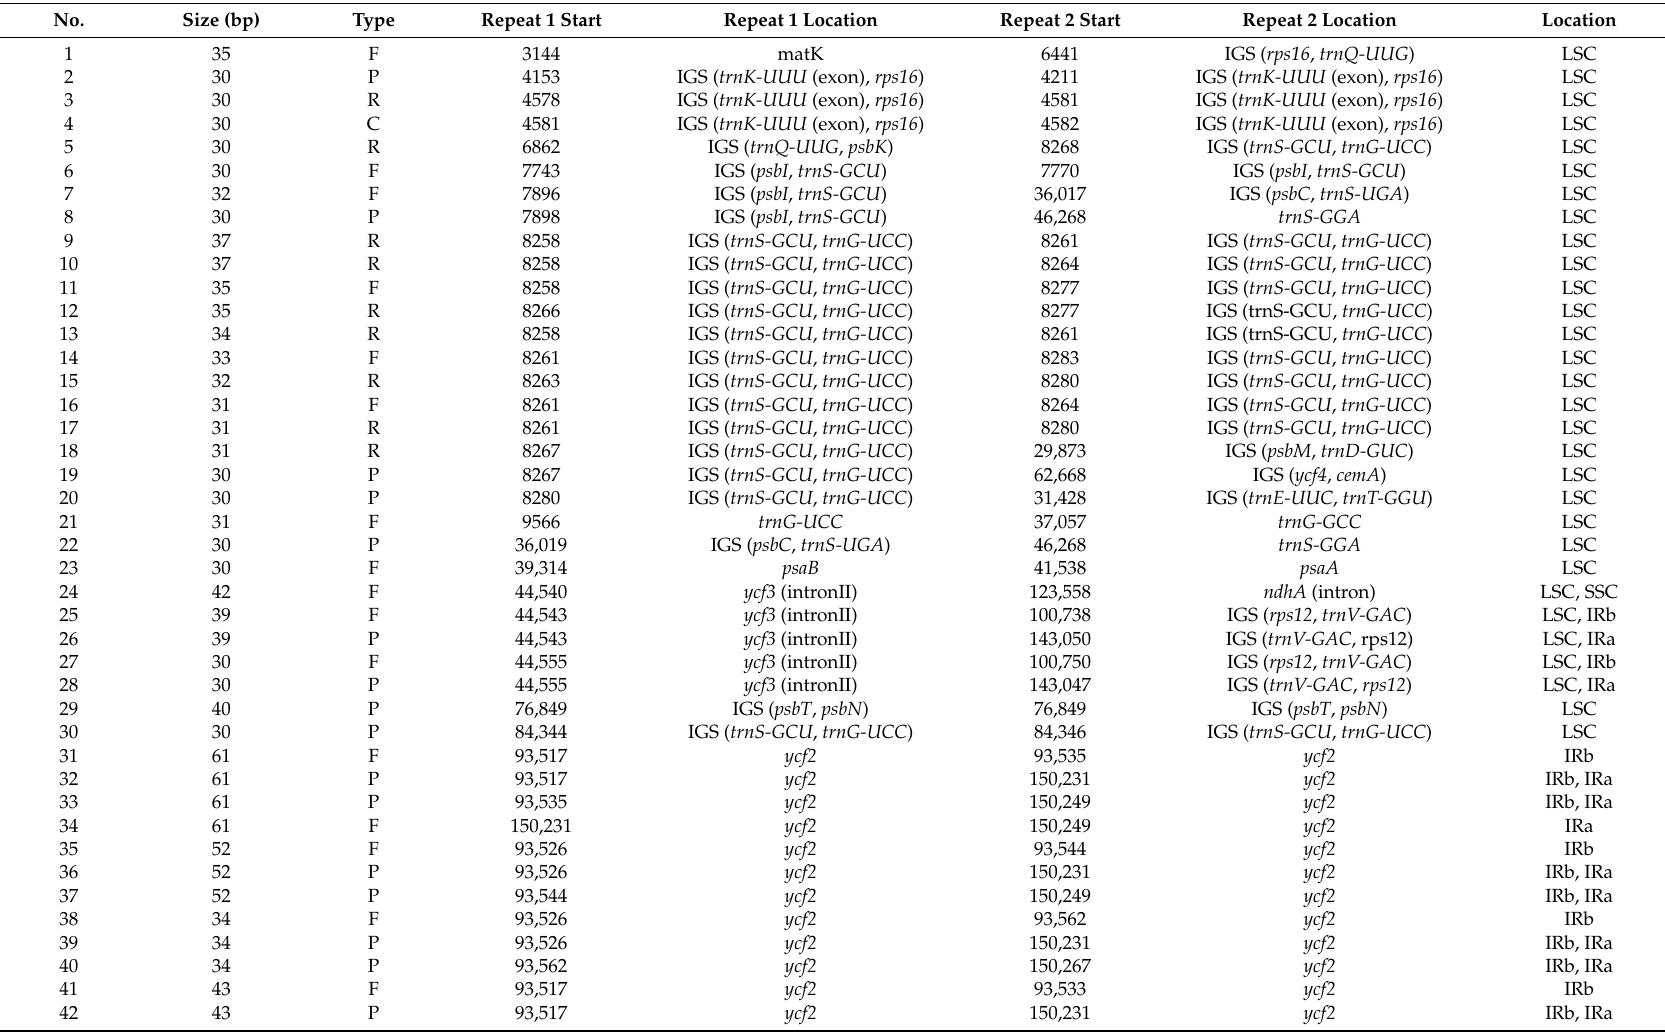
Table 5. Repeat sequences distribution in the T. paniculatum (Jacp) Gaertn chloroplast